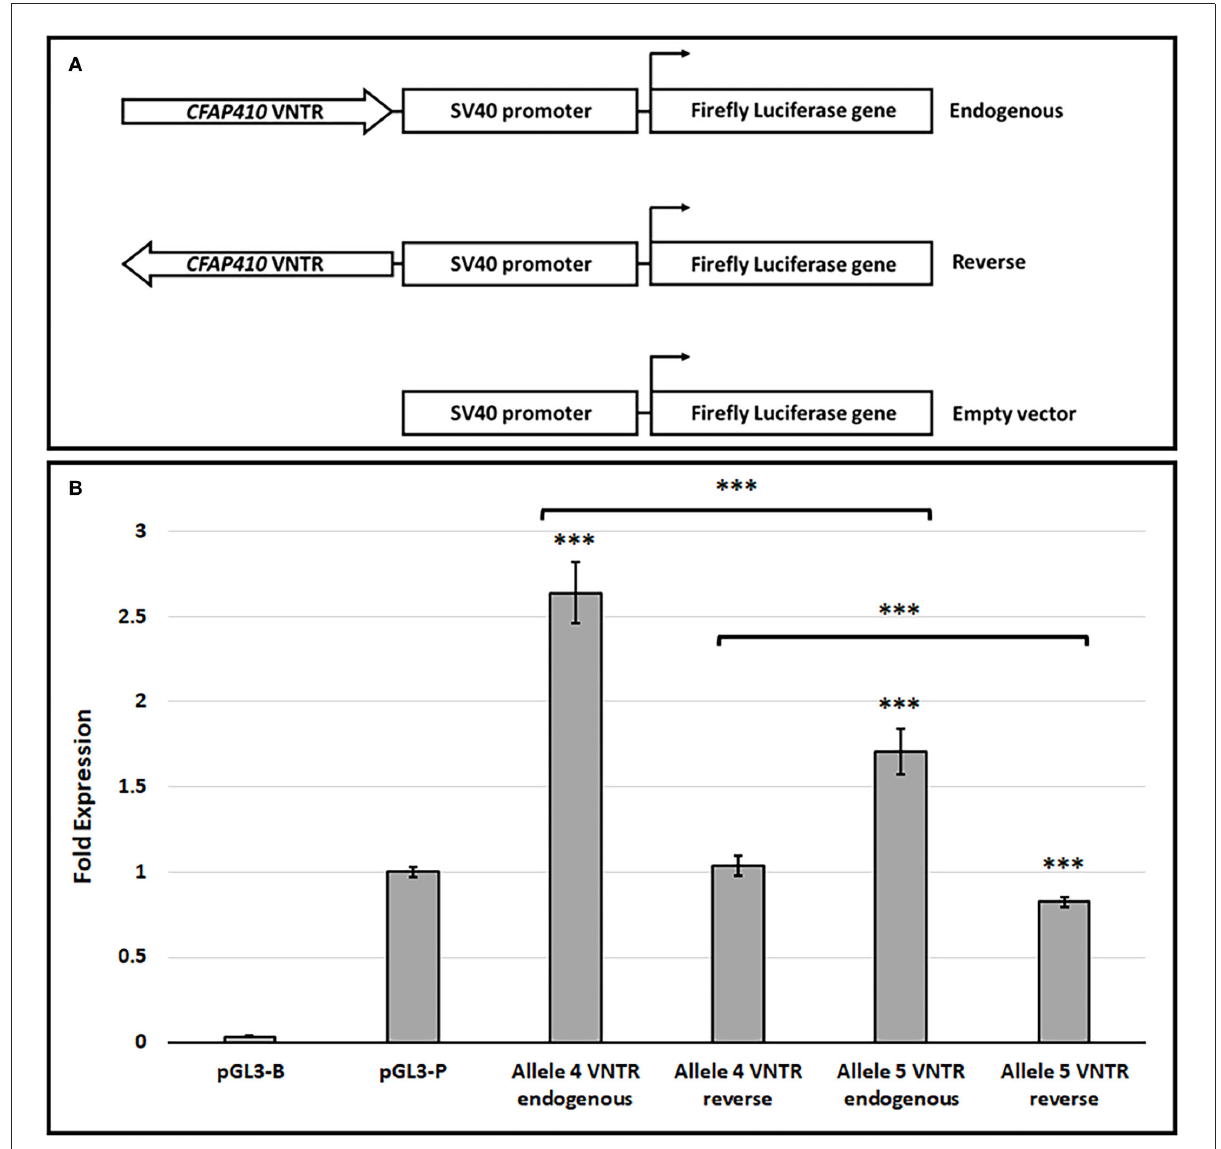
FIGURE3 The CFAP410 VNTR shows functional properties in the pGL3-P vector in the HEK293 cell line. (A) Schematic for VNTR containing constructs and pGL3 vectors (Promega) used in the luciferase assay. (B) The fold activity of alleles 4 and 5 of the CFAP410 VNTR in the endogenous (forward) orientation within the pGL3P vector, normalised to the internal control Renilla luciferase (Biological replicate n = 3, technical replicate per assay n = 4). The promoter-less vector (pGL3-B) was included as a negative control. T-test was used to compare VNTR-containing constructs to SV40 unmodified vector (pGL3-P) and to compare all VNTR containing constructs against each other. *** P = <